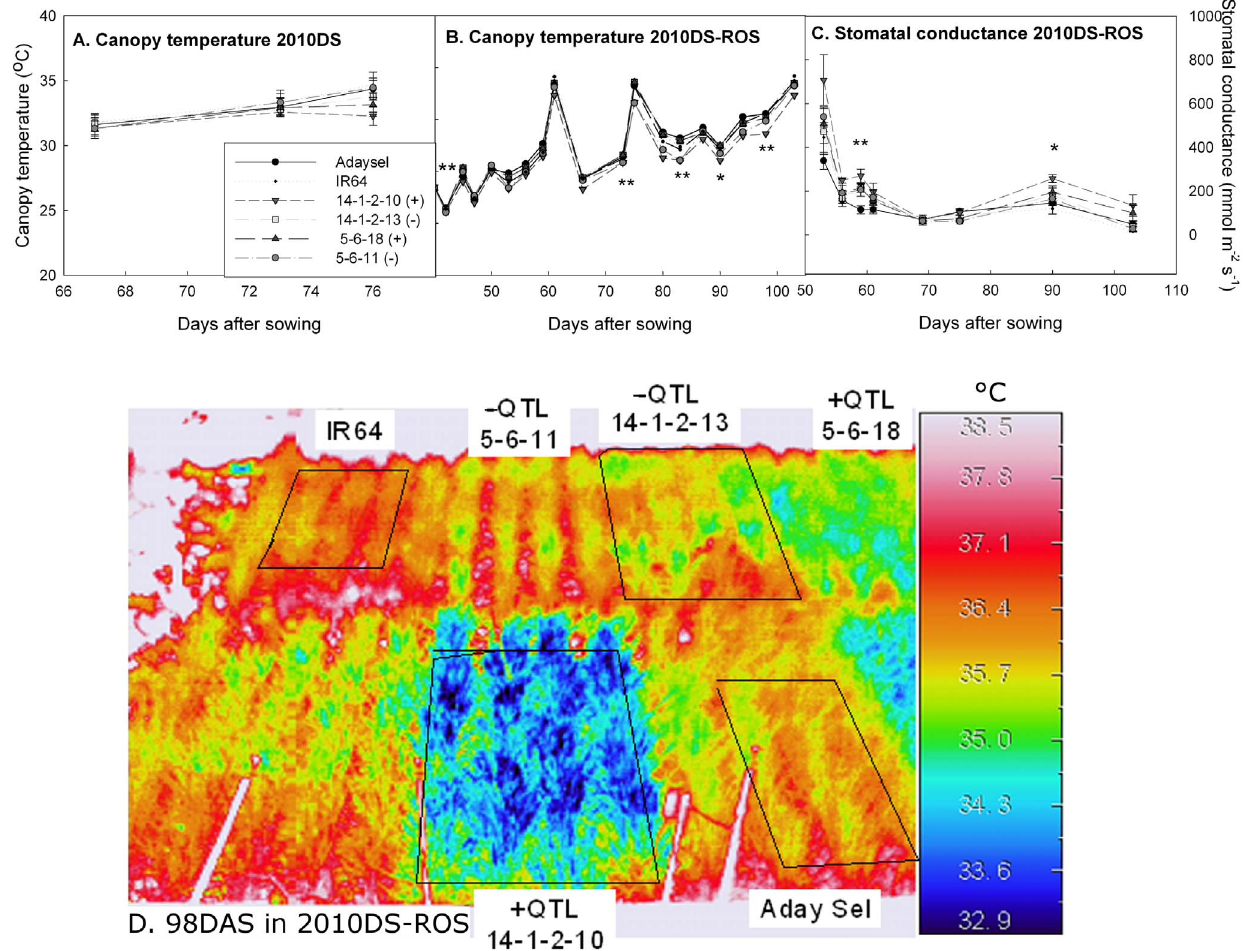
Figure 1. Canopy temperature dynamics over the A. 2010DS and B. 2010DS-ROS, as measured mid-day on sunny days with an infrared camera, and C. stomatal conductance during the 2010DS-ROS. Significant differences among lines are indicated by *(p , 0.05) and **(p , 0.01). D. Infrared thermal image showing contrasting canopy temperatures of + QTL and –QTL lines, taken 98 days after sowing (DAS) in